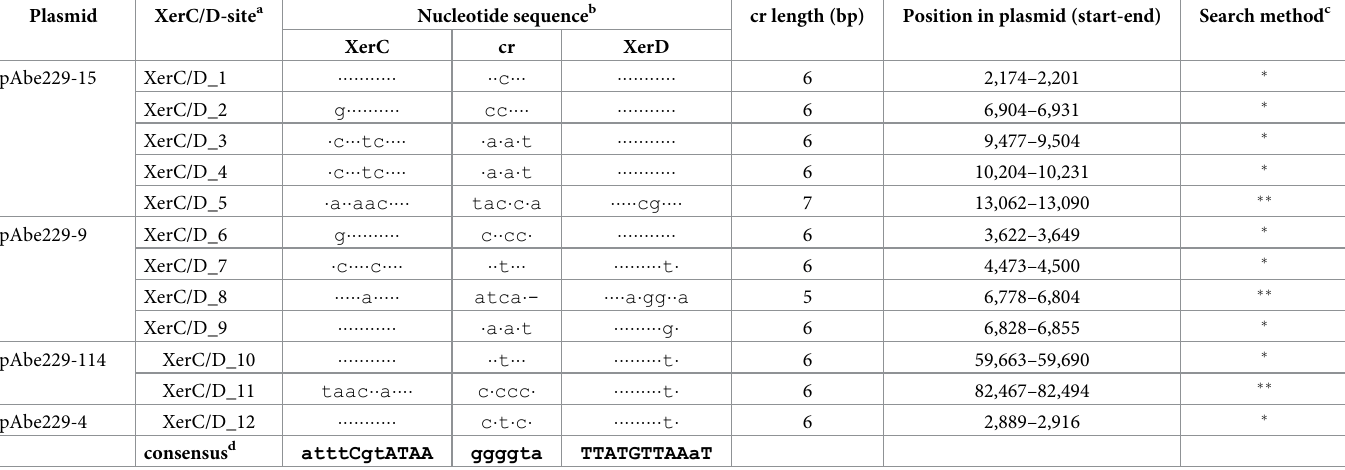
Table 4. XerC/D sites in HPC229